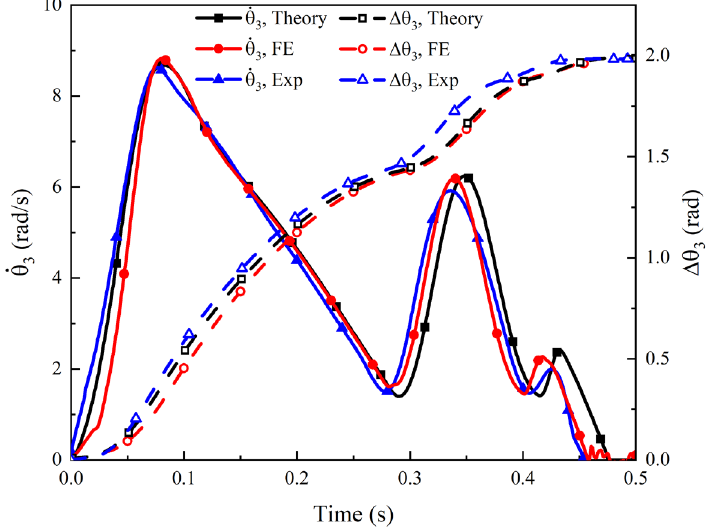
Figure 11. Comparison of the deployment angle and angular velocity of the flap panel from theoretical, FE, and experimental results.